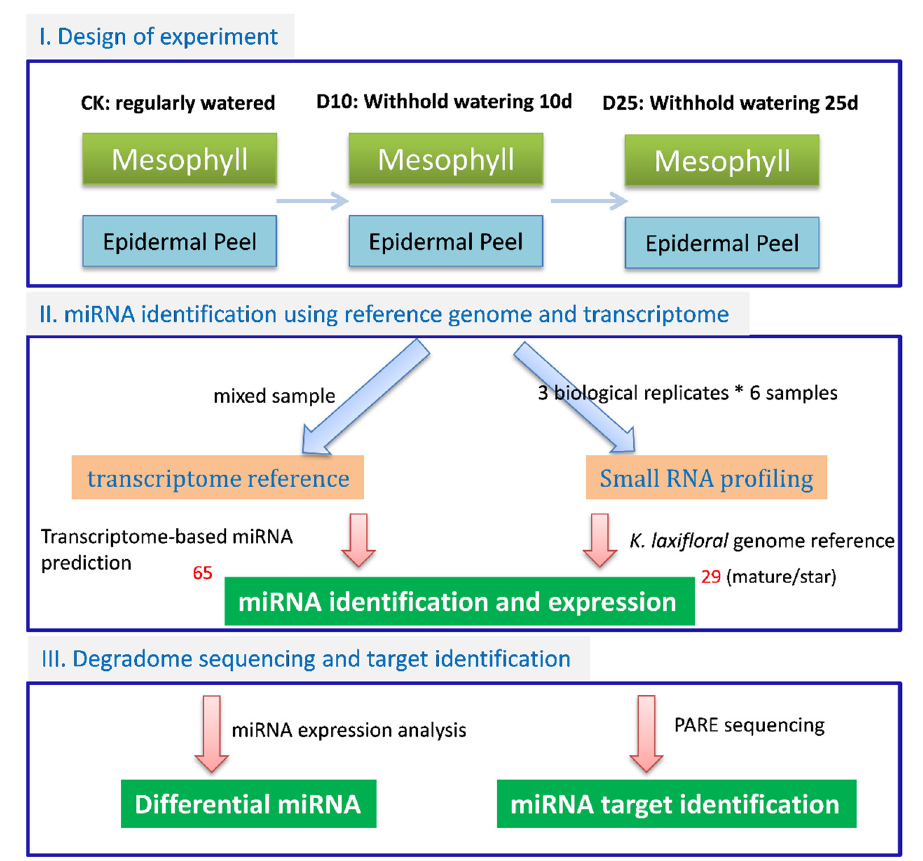
Figure 1. The experimental design for transcriptome sequencing and pipeline of data analysis. Drought treatments (10 and 25 days without watering) were performed using K. marnieriana cuttings that were clonal propagated and subsequently sampled for sequencing. The transcriptome and reference genome sequence were used for miRNA identification; the combined miRNA dataset was further analyzed for expression profiling. To reveal the targets of miRNAs, the Parallel Analysis of RNA Ends sequencing was performed using the mixed RNA samples from abovementioned tissues.